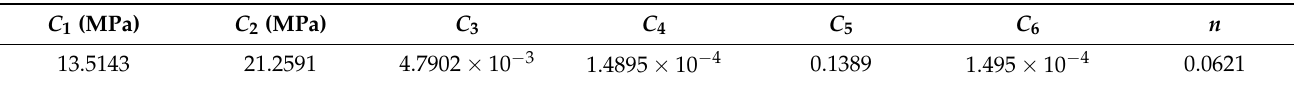
Table 3. Parameter constants of the Modified-Zerilli–Armstrong